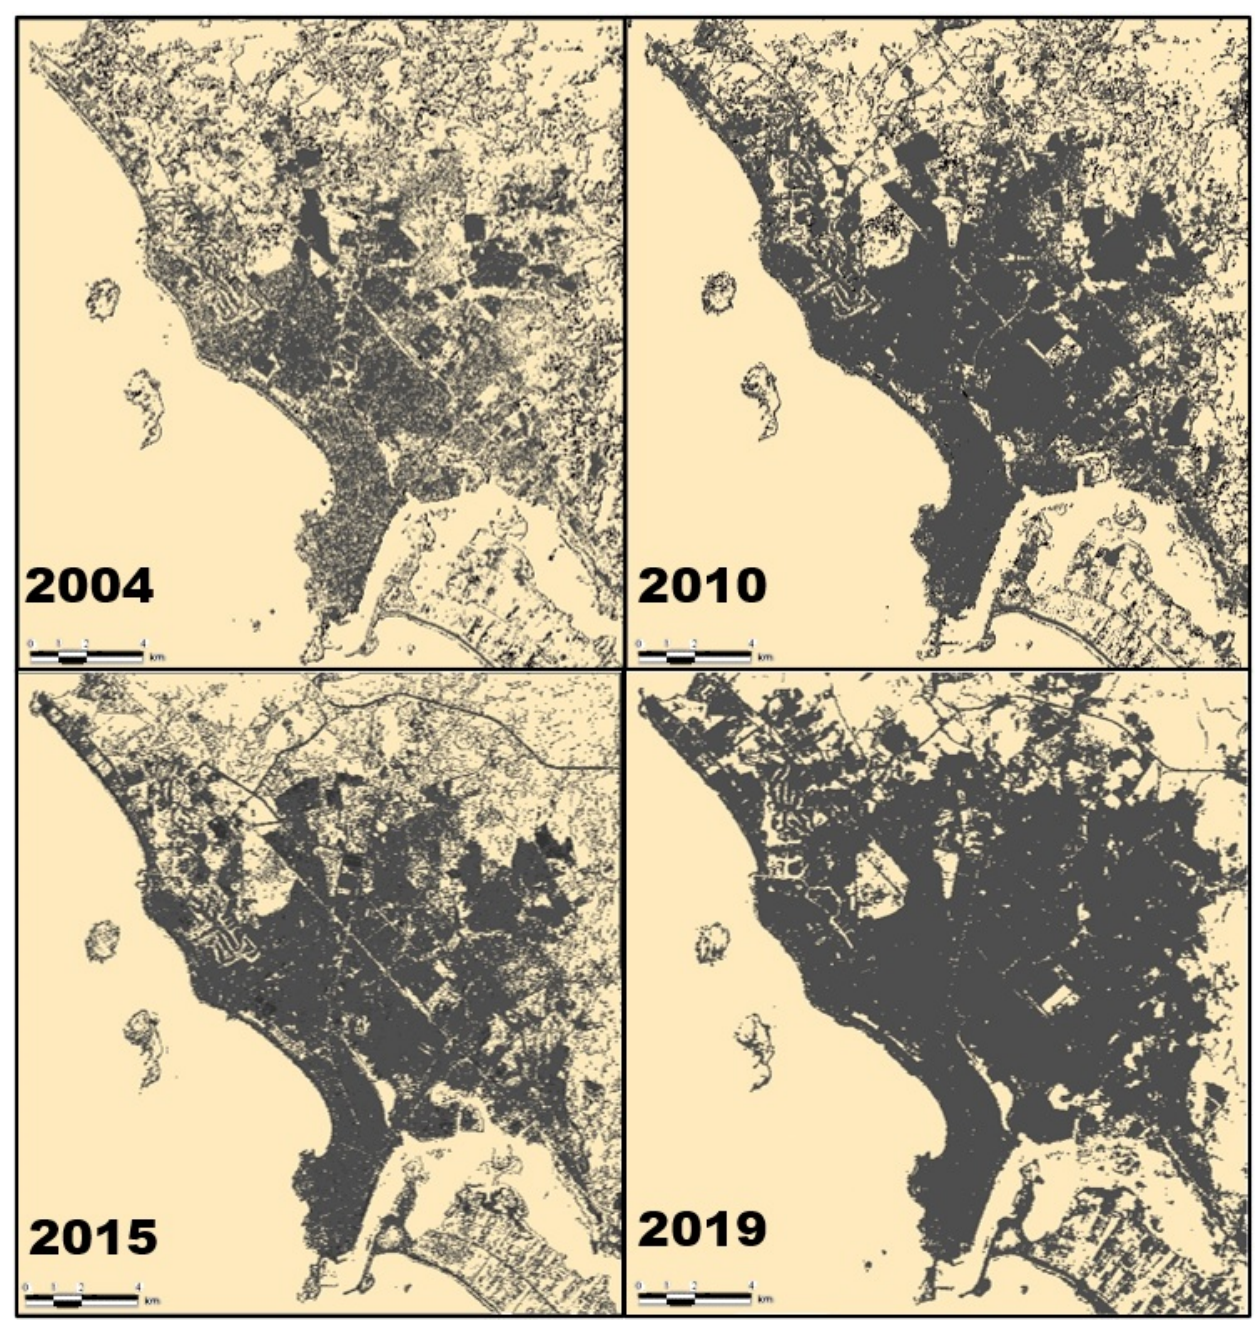
Figure 11. Digitization of satellite images to quantify urbanization in Mazatlan, 2004–2019. The dark gray indicates urban area.